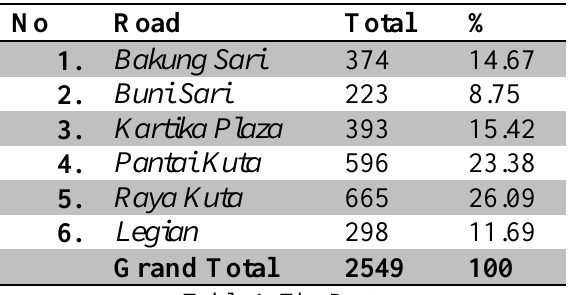
Table 1. The Data